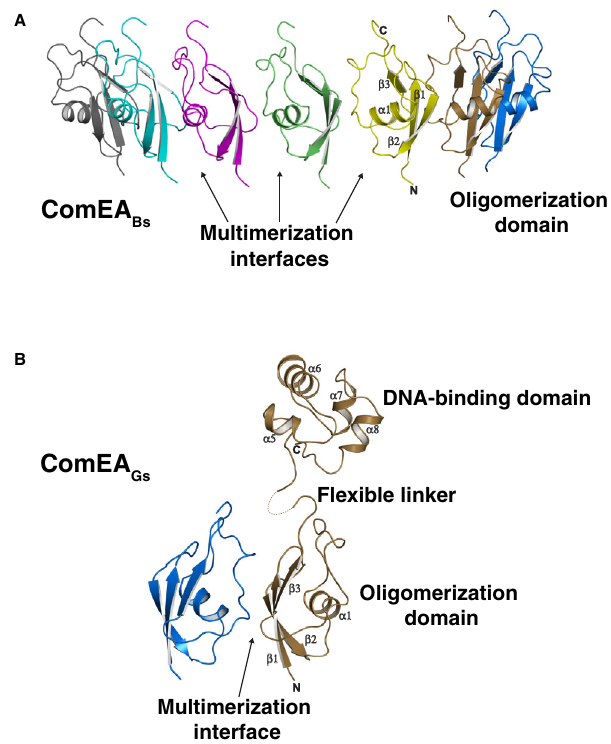
Fig.2|ComEAX-raycrystalstructures. A)X-raycrystalstructureofComEA Bs .One asymmetric unit containing seven protomers is shown. Arrows here point to only three of the six multimerization interfaces in the asymmetric unit. B) X-ray crystal structure of ComEA Gs . One asymmetric unit containing two protomers is